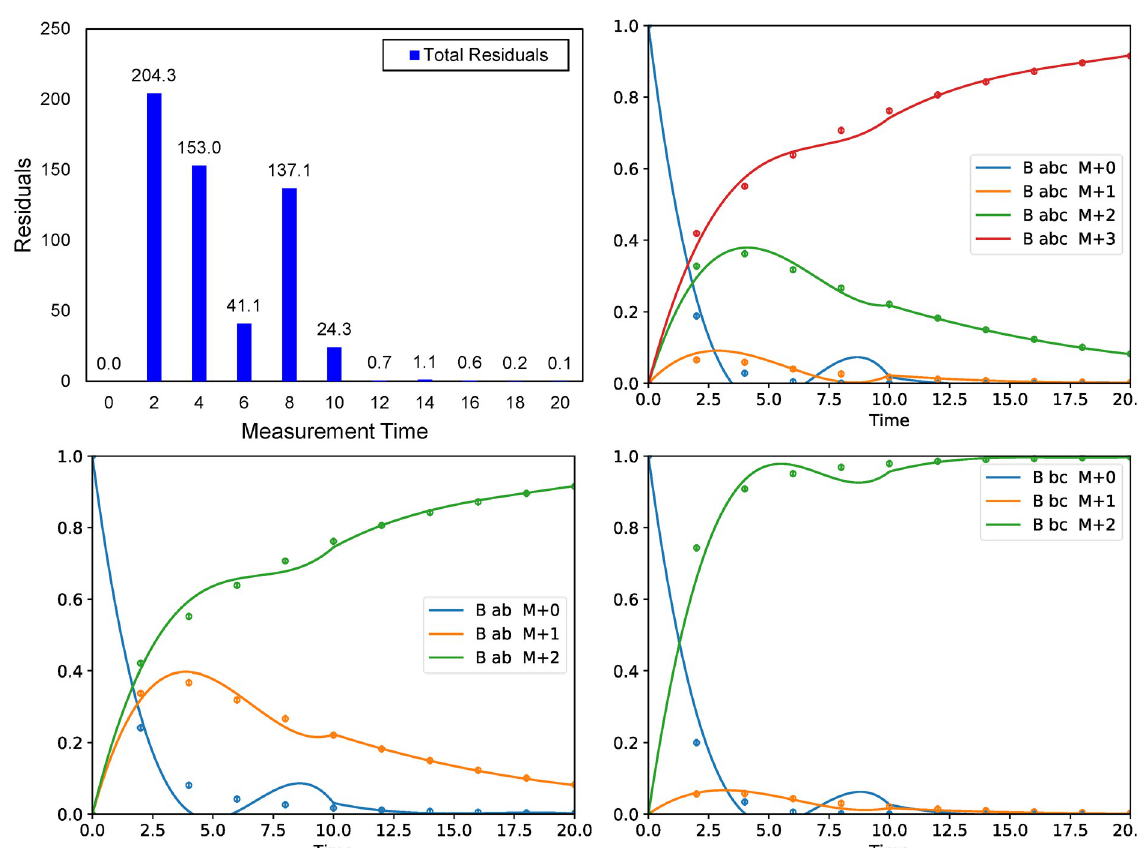
Fig 5. The result of assigning a larger than permissible step size in the stiff region for the toy network. The total measurement residuals converged upon by eiFlux when the time domain is divided into two intervals: [0, 10] and [10, 20] is plotted showing that the poor approximation in the first time interval does not significantly affect the solution in the later time interval. The solution is plotted for all measured fragments of B. Clearly, the solution is poorly approximated in the first time interval, but the solution in the second interval remains accurately approximated and asymptotically approaches the true steady-state